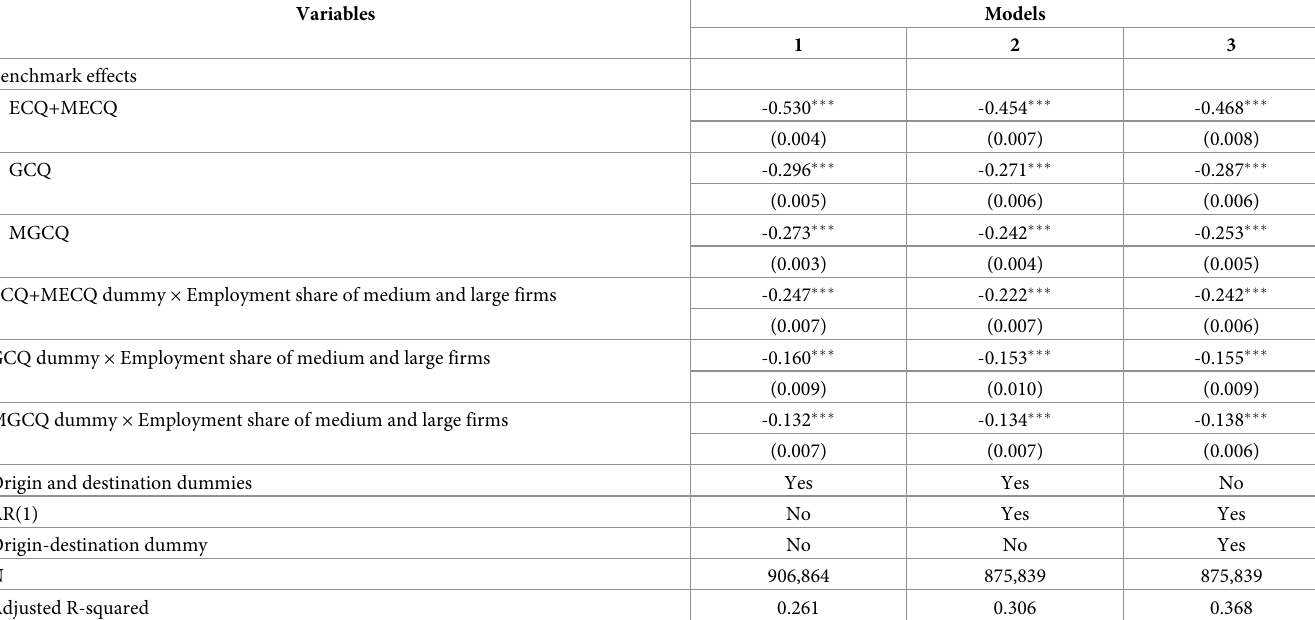
Table 5B. Effects of lockdown measures by destination city firm size composition (afternoon flows leaving the top 300 cities).